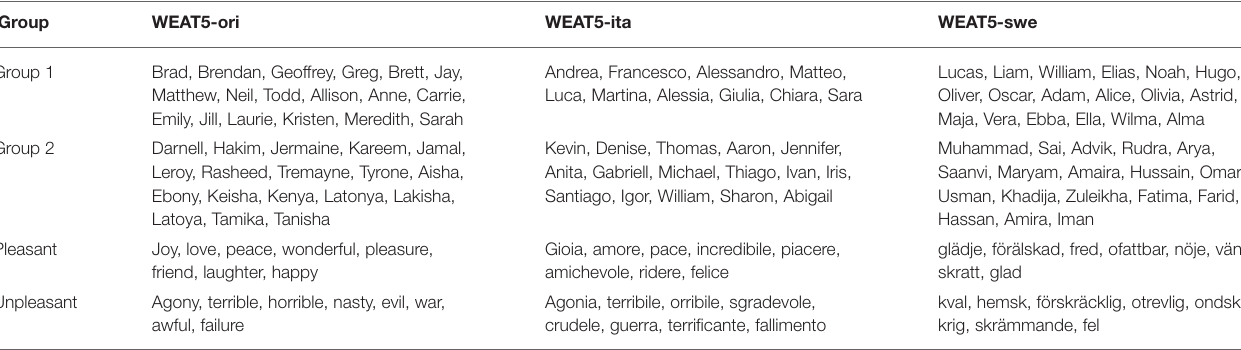
TABLE 2 | The terms from the original WEAT5 experiment (Caliskan et al., 2017) and our adaptations/translations to Italian and Swedish. Group WEAT5-ori